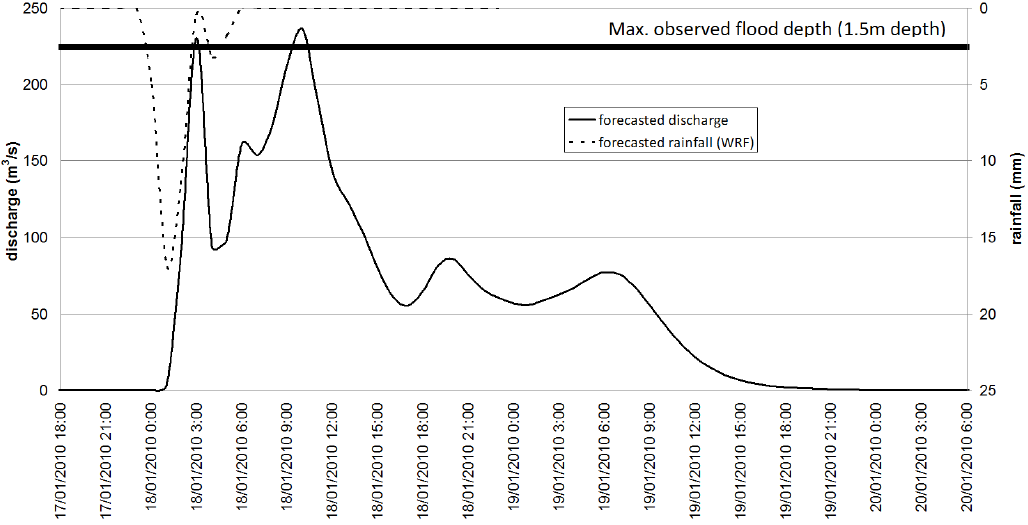
Fig. 12. Forecasted discharge at the outlet based on forecasted rainfall; the peak discharge corresponds to an observed flood depth of 1.5m at the outlet of Wadi Watir.